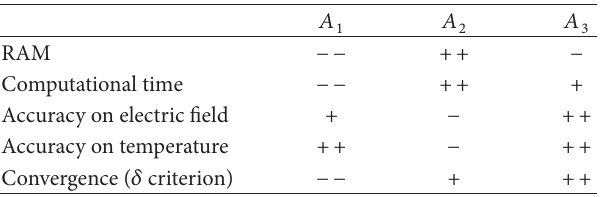
Table 1: Summary of the efficiency of each strategy, 𝐴 1 , 𝐴 2 , and 𝐴 3 , as a function of the investigated